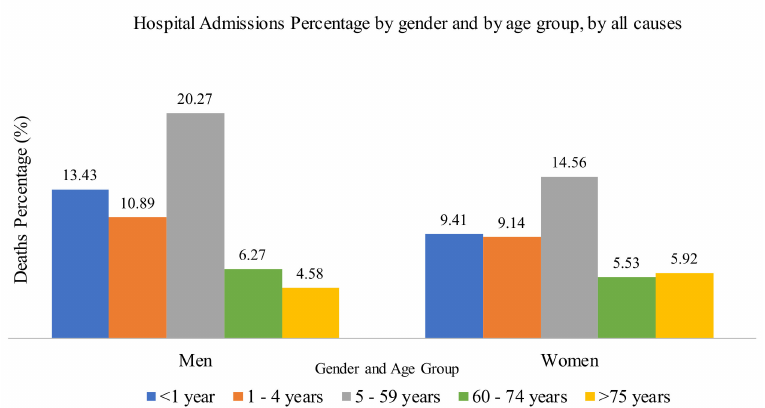
Figure 7. Hospital admission percentage by gender and age group for all causes.